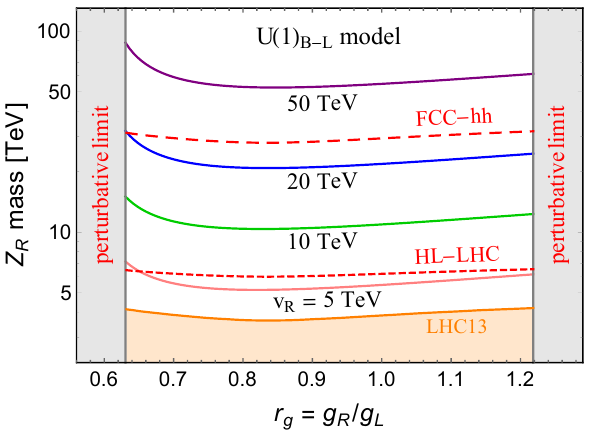
Figure 3 . Current LHC13 constraints on Z R mass in the U(1) B (cid:0) L model (shaded orange) as function of r g = g R =g L , and future prospects at the HL-LHC 14 TeV with an integrated luminosity of 3000 fb (cid:0) 1 (short-dashed red) and the 100 TeV collider FCC-hh with a luminosity of 30 ab (cid:0) 1 (long-dashed red). The vertical shaded regions are excluded by the perturbativity constraints given in eq. (3.3). The pink, green, blue and purple contours show the variation of the Z R mass with respect to r g , with the RH scale v R = 5, 10, 20, 50 TeV, respectively.